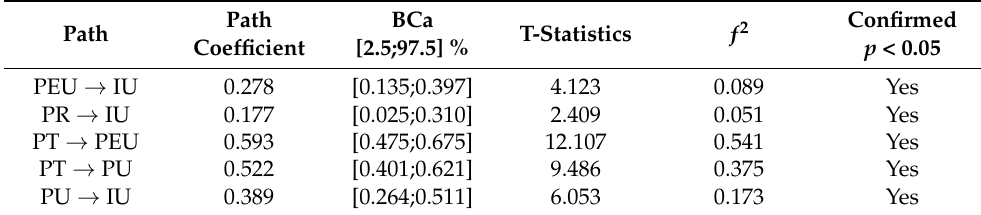
Table 7. Results supporting hypotheses.